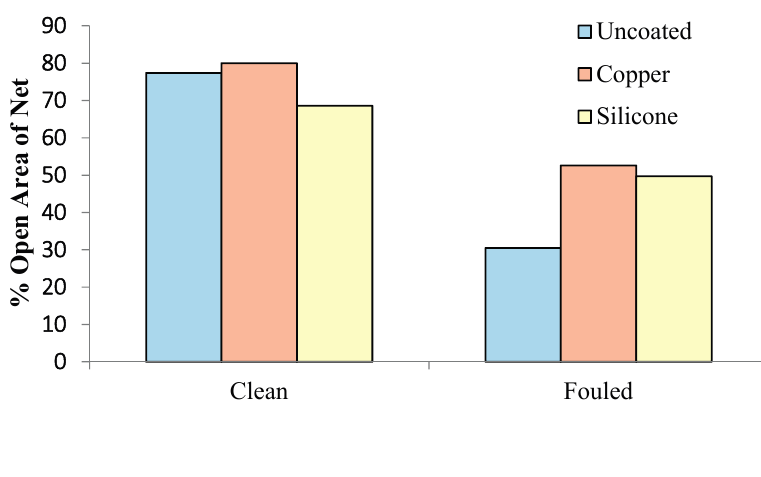
Figure 2. Average percent area of net open.